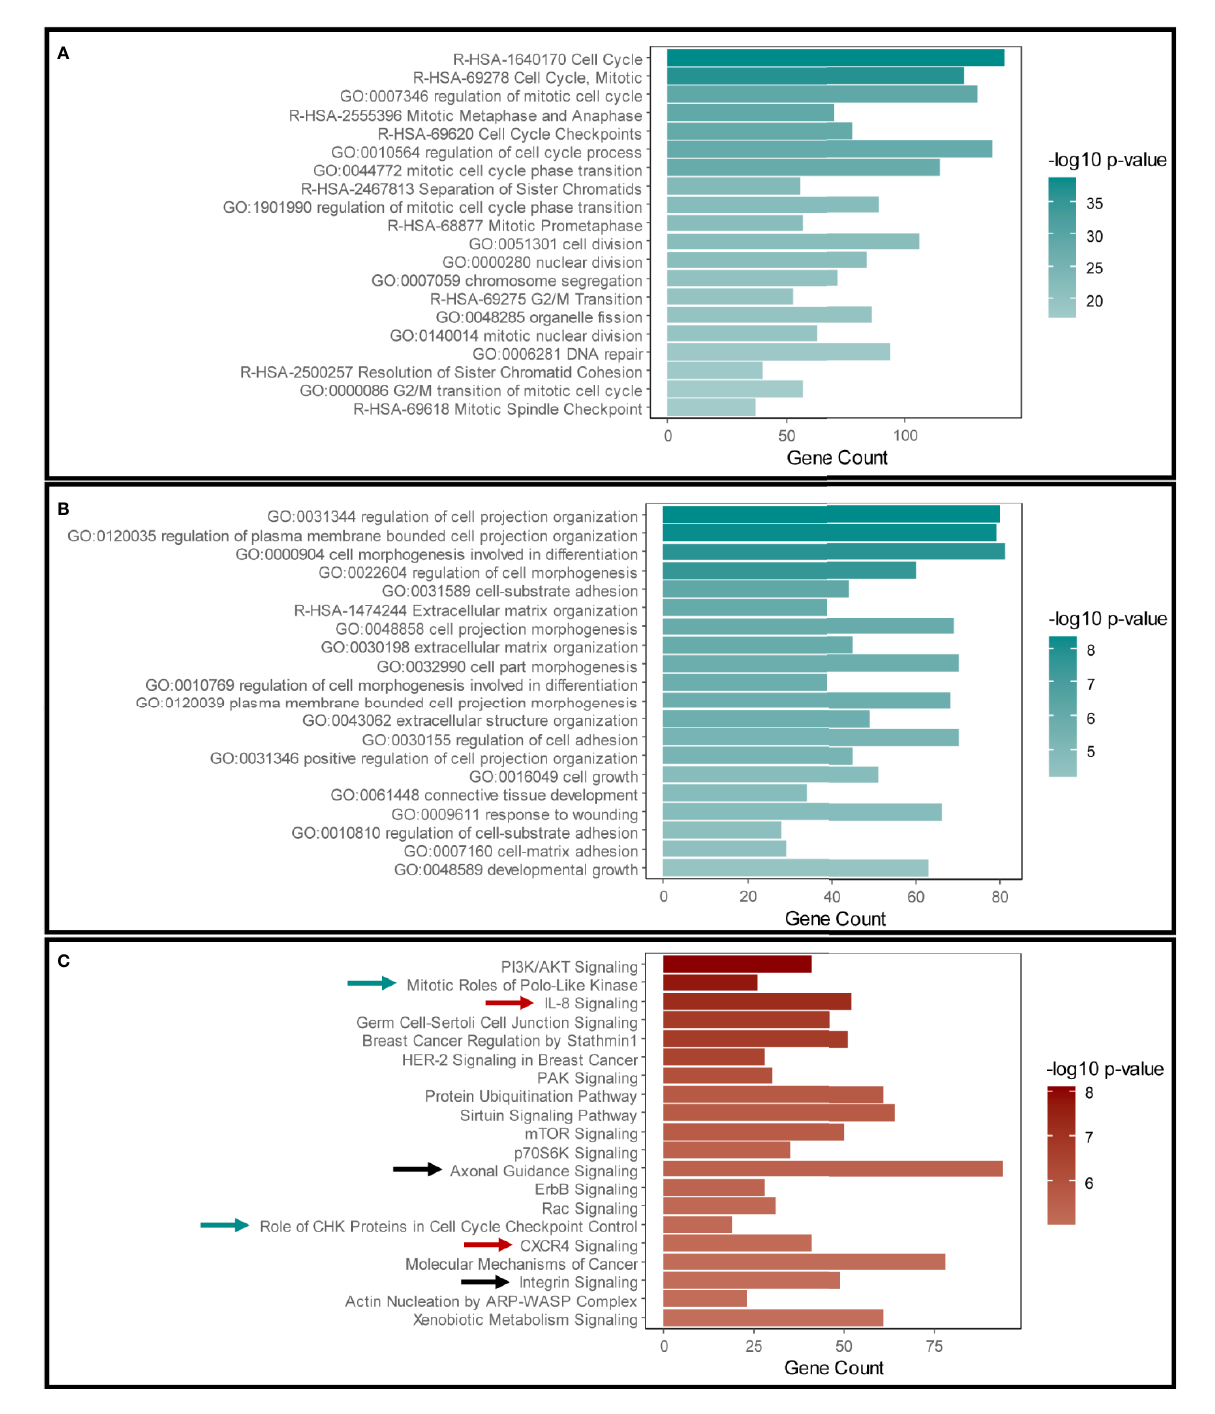
FIGURE 1 | Validation of Snail inhibition and p53 restoration in GN25 treated cells. The top 20 enriched pathways and functional clusters in (A) the upregulated genes and (B) downregulated genes in the GN25 treated cells analyzed using Metascape annotation tool (C) . Top 20 pathways enriched in the differentially expressed genes in GN25 treated cell (both up- and down-regulated genes) using IPA. Green arrows indicate cell cycle related pathways; black arrows indicated cell morphogenesis related pathways; and black arrows indicate immune response related